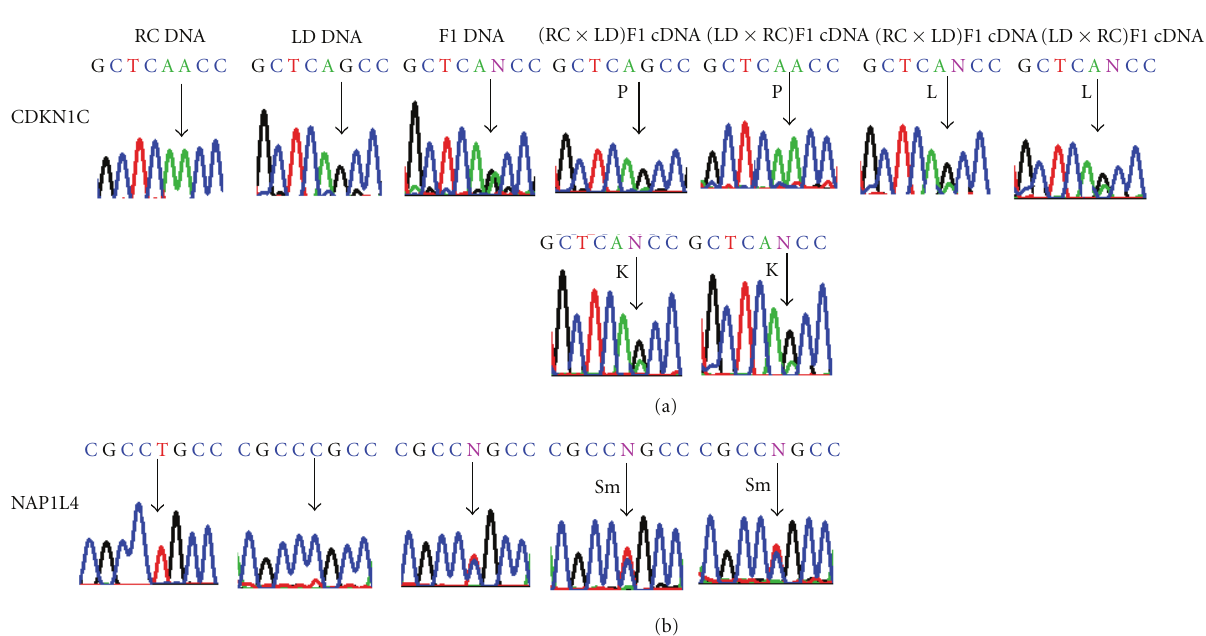
Figure 2: Maternal or biallelic expression of CDKN1C (a) and NAP1L4 (b) in 0-day pigs. RC: Rongchang pigs, LD: Landrace pigs, P: placenta, L: lung, K: kidney, Sm: skeletal muscle. Arrows indicate SNP